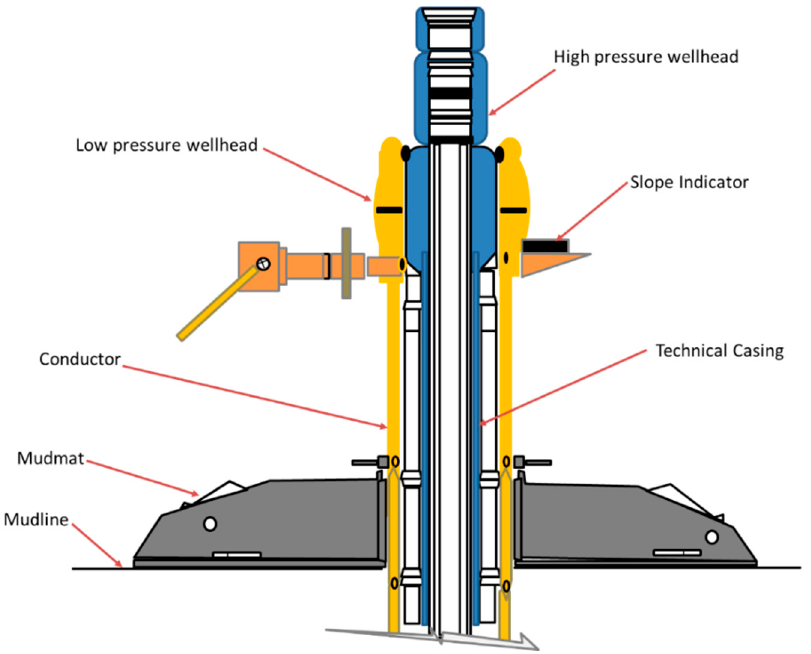
Figure 1. Subsea wellhead structure.